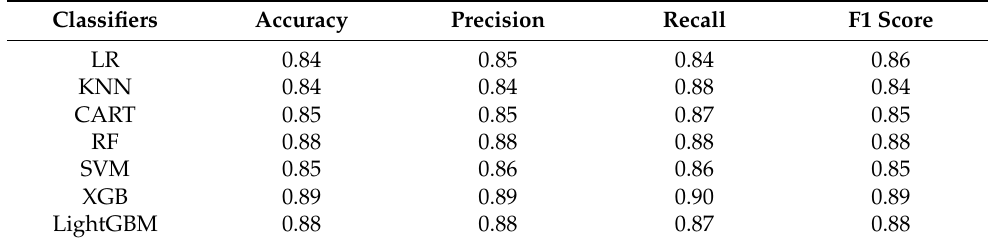
Table 5. Performance comparison of the generated prediction